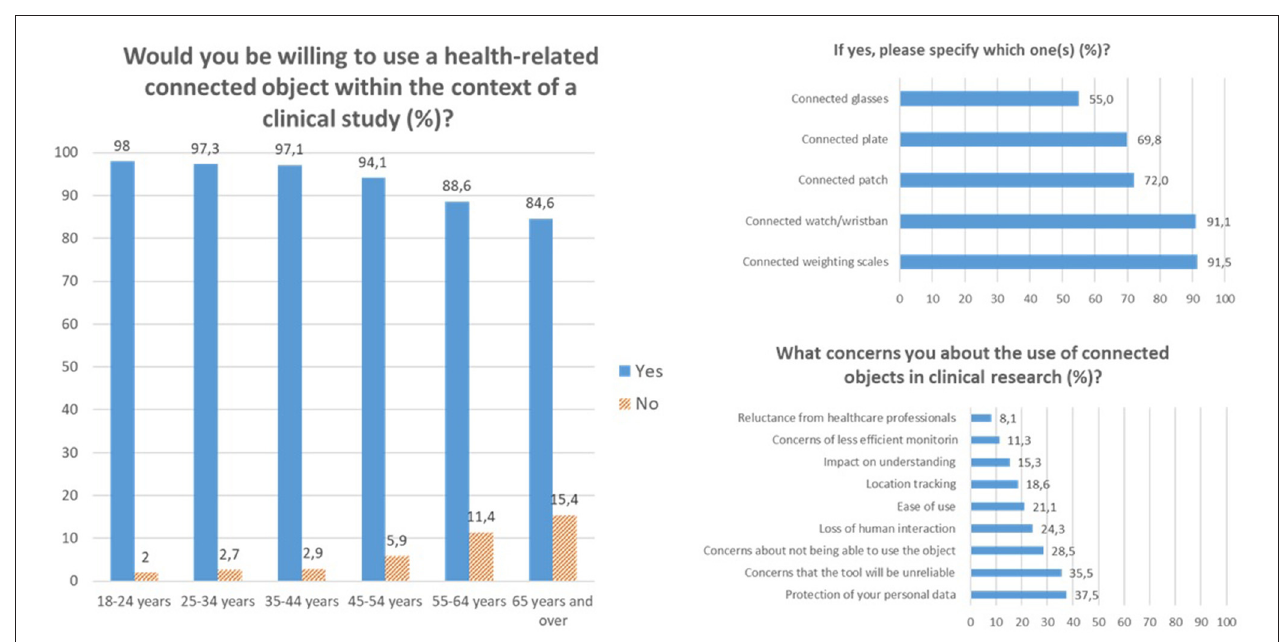
FIGURE 2 | Expectations and concerns related to the use of health-related connected devices in medical research. chi-square test. In case of global effect, pairwise proportion